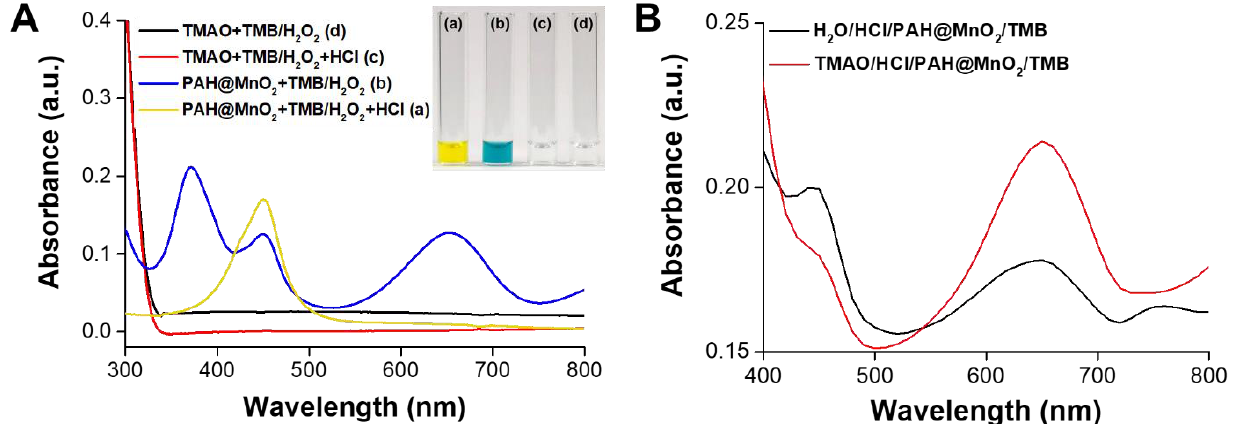
Figure 2. ( A ) UV-vis absorption spectra and visual colour changes of the catalysed oxidation of TMB in the absence or presence of PAH@MnO 2 ; the inset is a corresponding digital photo; ( B ) UV-vis absorption spectra of the catalysed oxidation of TMB in the absence or presence of TMAO to prove the mechanism of proton depletion by TMAO.